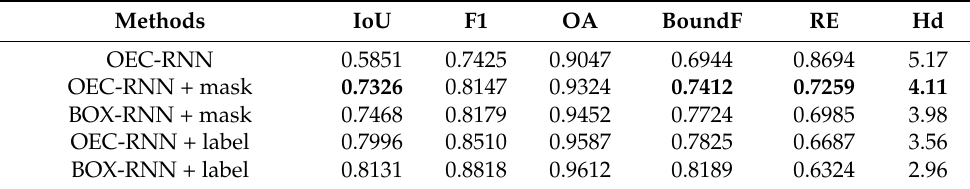
Table 3. Ablation experiment evaluation